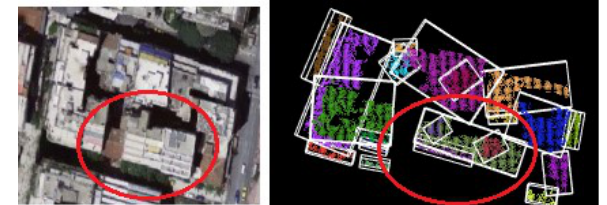
Figure 7. An example of false-detection of noise. In the red circles, the removed roof top elements are presented in the orthophoto (left) and in the result of the first step of the proposed methodology (right)